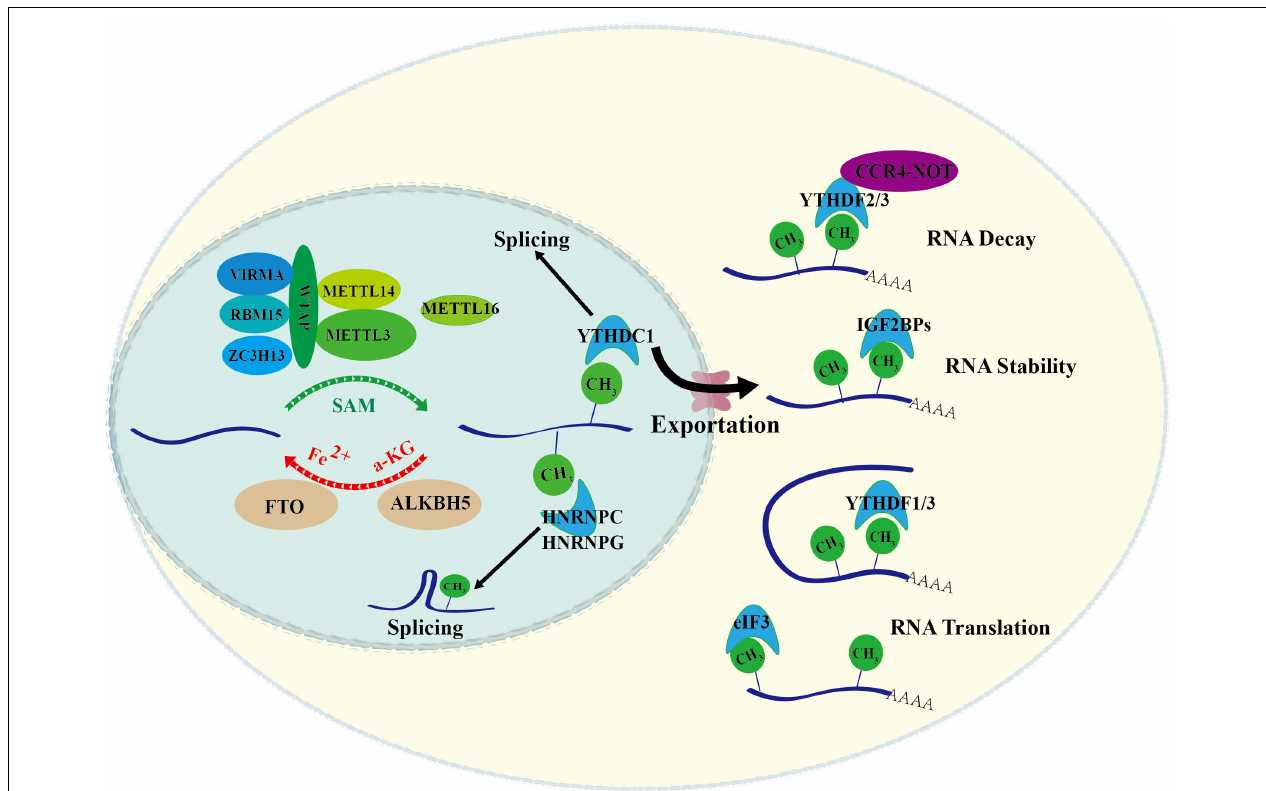
FIGURE 1 | Overview of RNA m 6 A modification. m 6 A methylation is catalyzed by the writer complex that is composed by METTL3, METTL14, WTAP, METTL16, VIRMA, RBM15, ZC3H13, and KIAA1429. m 6 A methylation is removed by erasers including ALKBH5 and FTO. The m 6 A-modified RNA reader proteins include YTHDF1/2/3, YTHDC1/2, IGF2BP1/2/3, and HNRNPs. These readers bind to the target RNA in an m 6 A-dependent manner, and affects the metabolic processes of RNA, such as pre-mRNA splicing, nuclear export, RNA decay, RNA stability and RNA